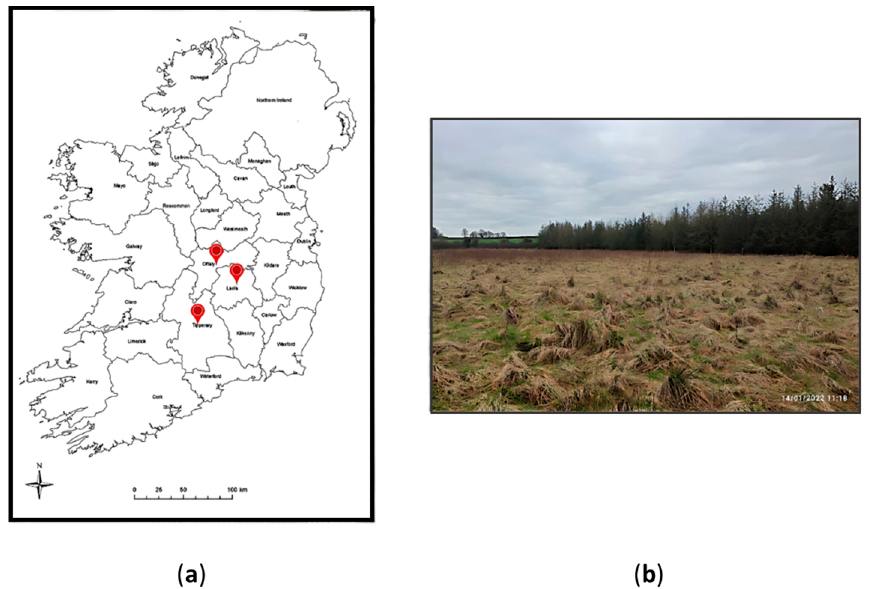
Figure 1. ( a ) A map of Republic of Ireland denoting the sampling locations in the midlands; ( b ) The geographical view of the cutaway peatland located in County Offaly on January 2022. (The average temperature was 6 °C).